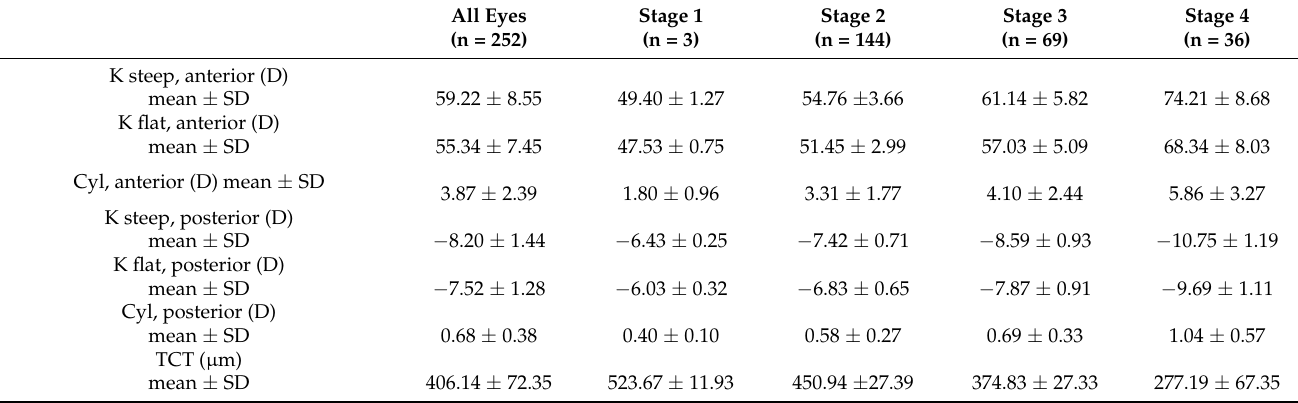
Table 2. Mean keratometry, cylinder and pachymetry values in the group classified with the Amsler–Krumeich classification.